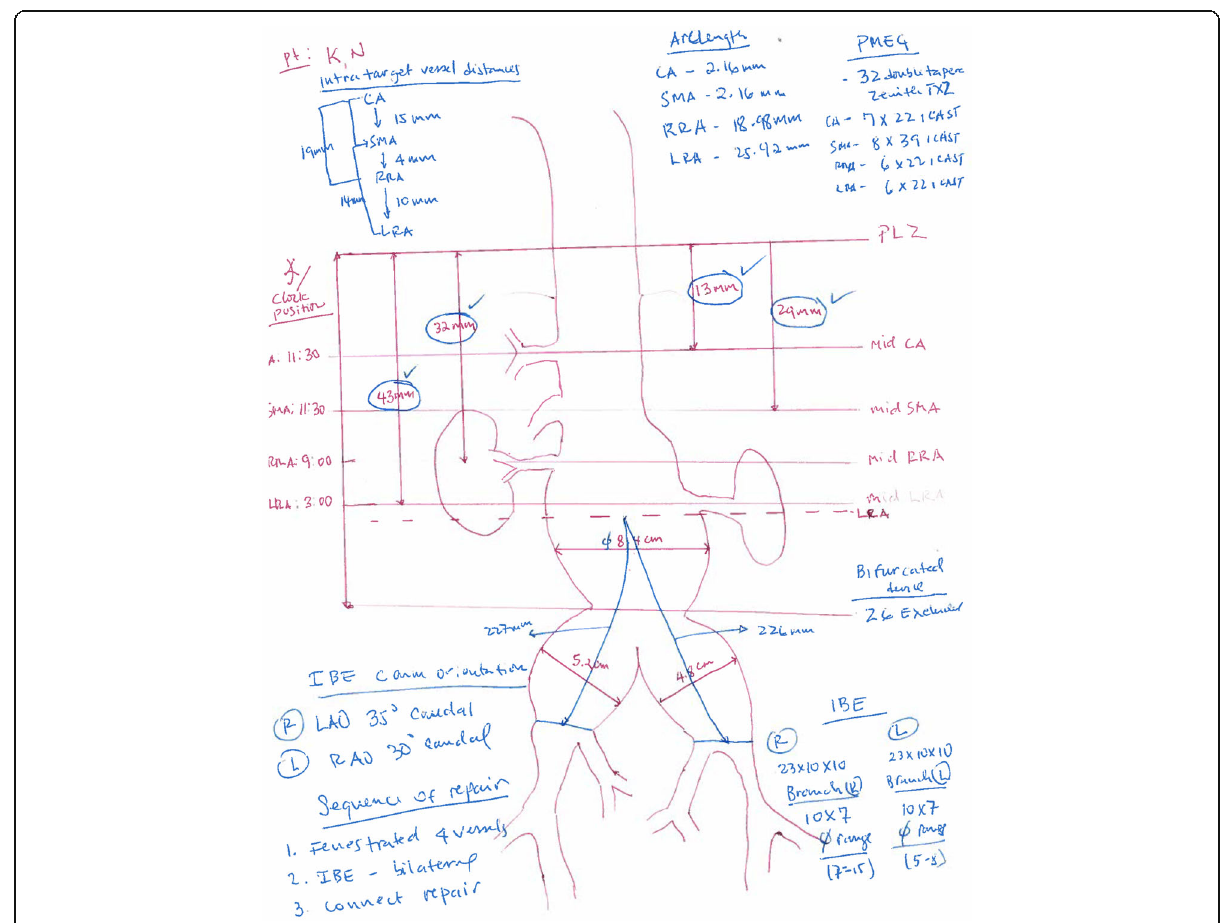
Fig. 1 Preoperative planning sheet. See all measurements obtained using centerline of flow prior to taking the patient to the operating room. This includes the location of the proximal landing zone, inner vessel diameter, distance from the top of the graft to every target vessel, distance from the top of the graft to the bifurcation. Size of target vessels and bridging stent graft to be used. In the illustrated case, the patient had large bilateral common iliac aneurysms that were treated at the same